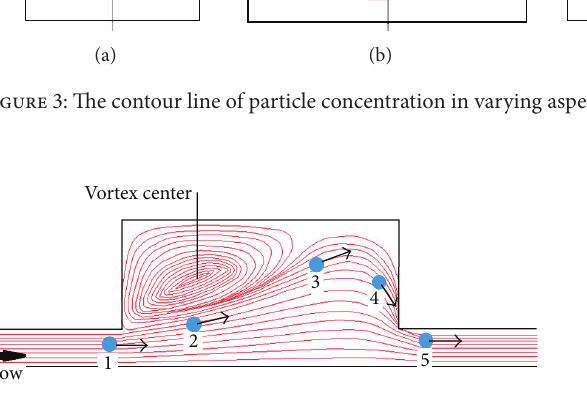
Figure 4: Microvortex structure and particle movement in an